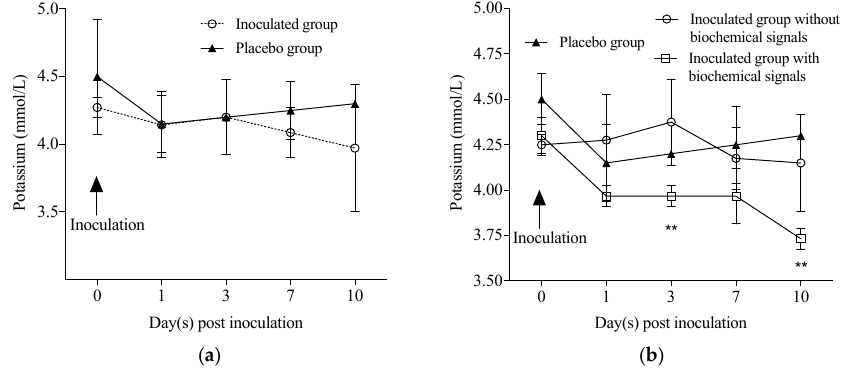
Figure 1. Sera potassium levels of cynomolgus monkeys. ( a ) Differences between the inoculated group and the placebo group. The arrow represents the inoculation time; ( b ) Comparison among the inoculated group without biochemical signals (Z7, V11, X9 and U13); inoculated group with biochemical signal (potassium decrease–T7, AB7 and AA7); and placebo group (V7 and X11). The arrow represents inoculation time. ** Statistical analyses between groups presented significance in reducing of K + levels at 3 and 10 dpi ( p < 0.01).